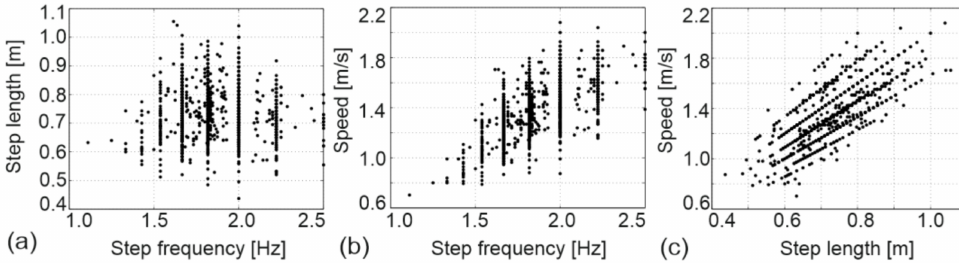
Figure 4. ( a ) Step length and ( b ) walking speed as functions of pacing frequency. ( c ) Pedestrian speed as a function of step length (adapted from [46]).